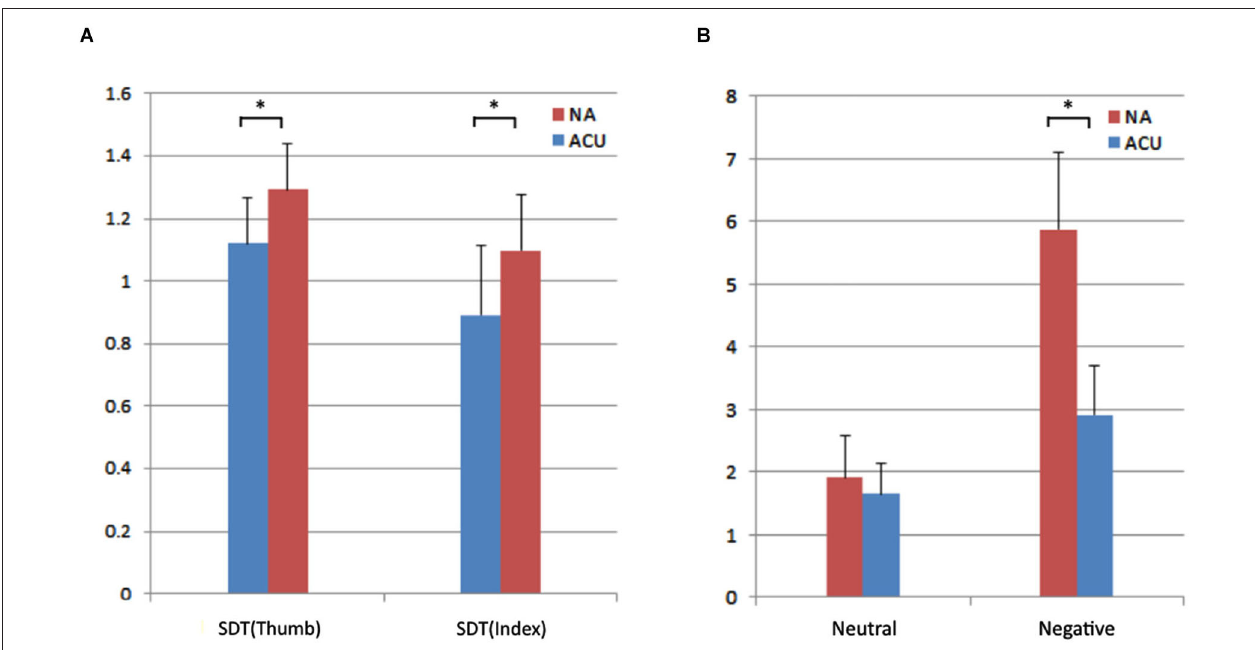
FIGURE 1 | Results of the behavioral analysis . (A) Results of tactile discrimination ability test. Acupuncturists had a significantly lower SDT than that of the control group for both fingers ( p < 0.001 and p = 0.001 for the thumb and the index finger respectively, Mann-Whitney test ). (B) Results of the emotion regulation proficiency test.